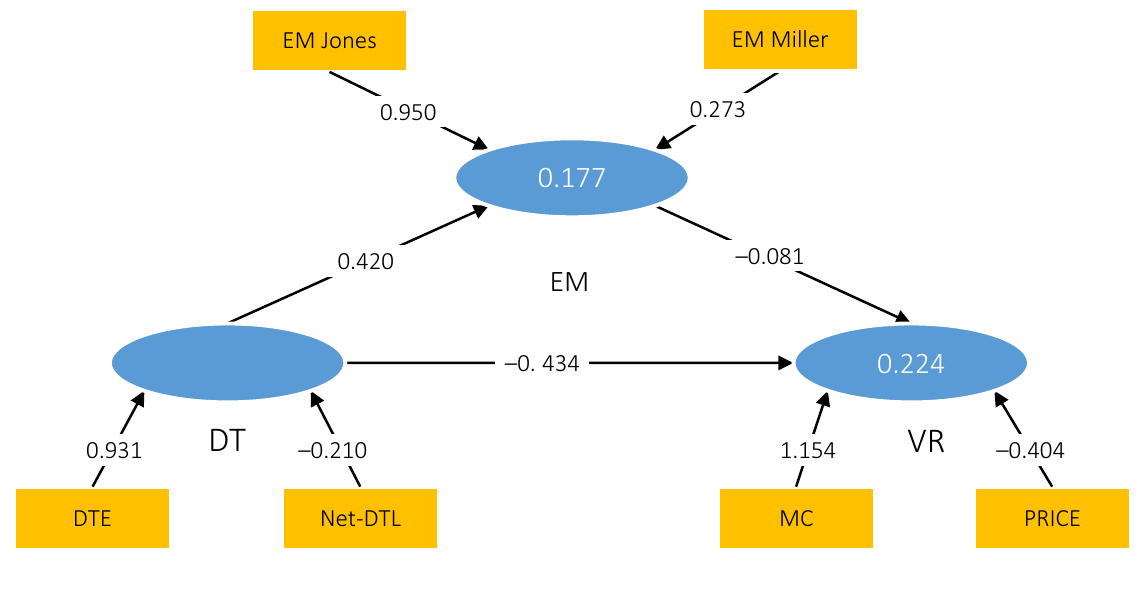
Figure 2. Structural model (outer